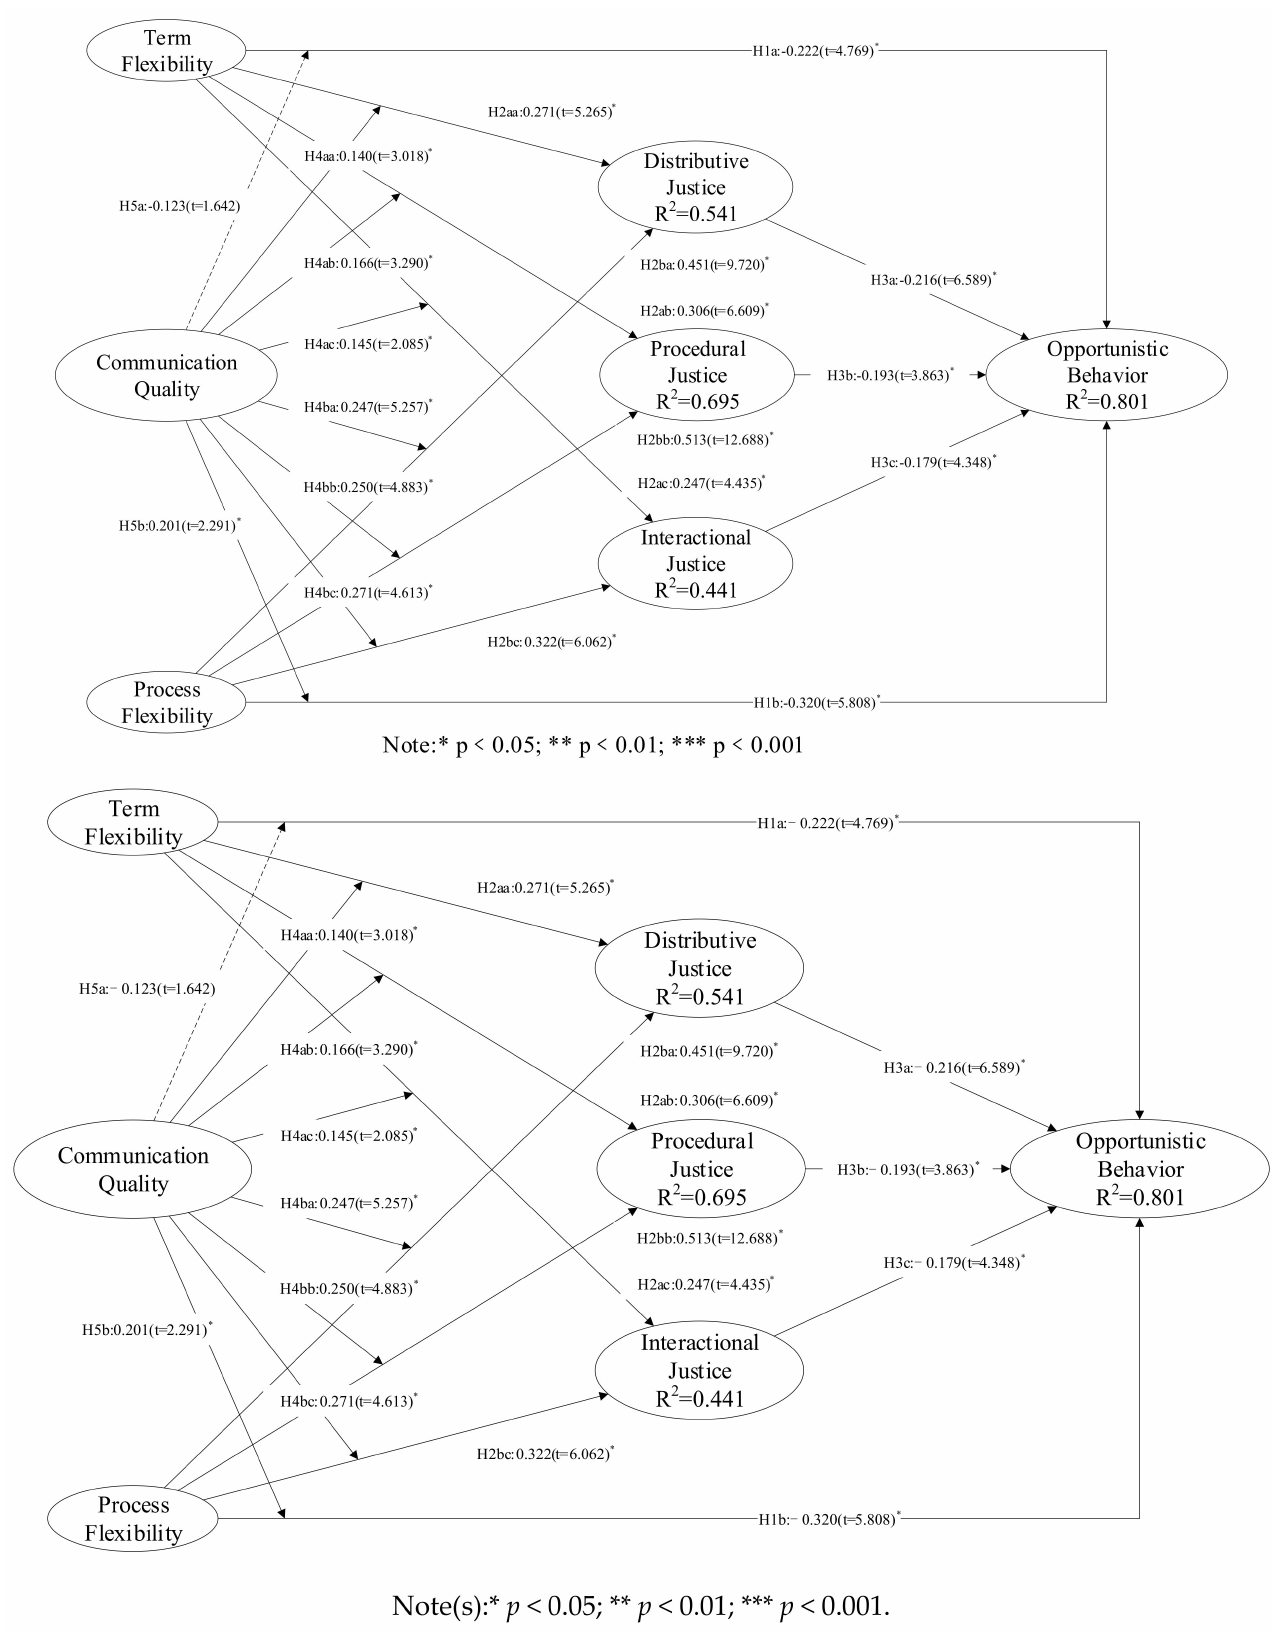
Figure 2. Results of structural